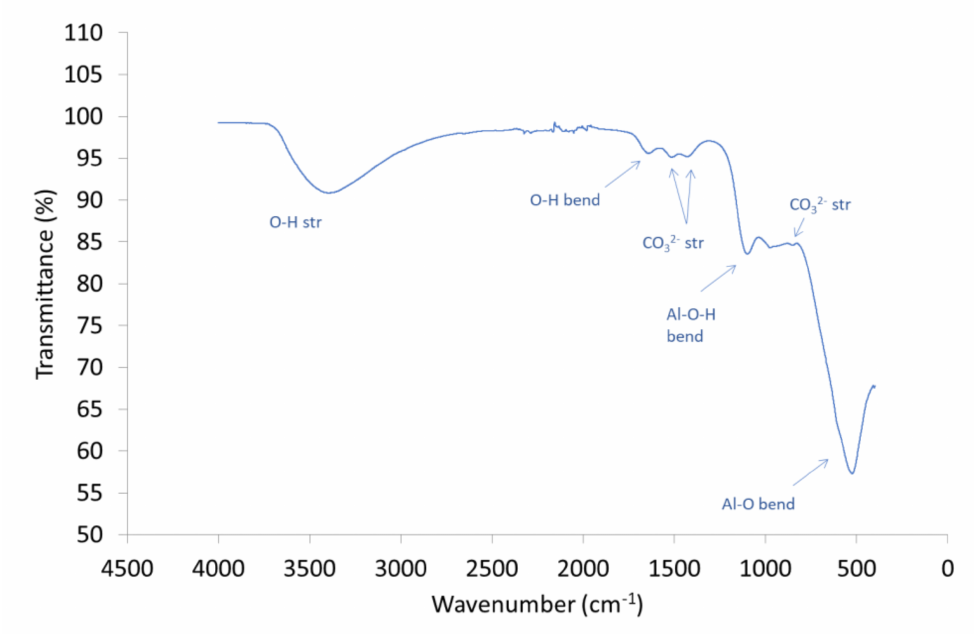
Figure A3. FTIR spectrum of the amorphous aluminium hydroxide